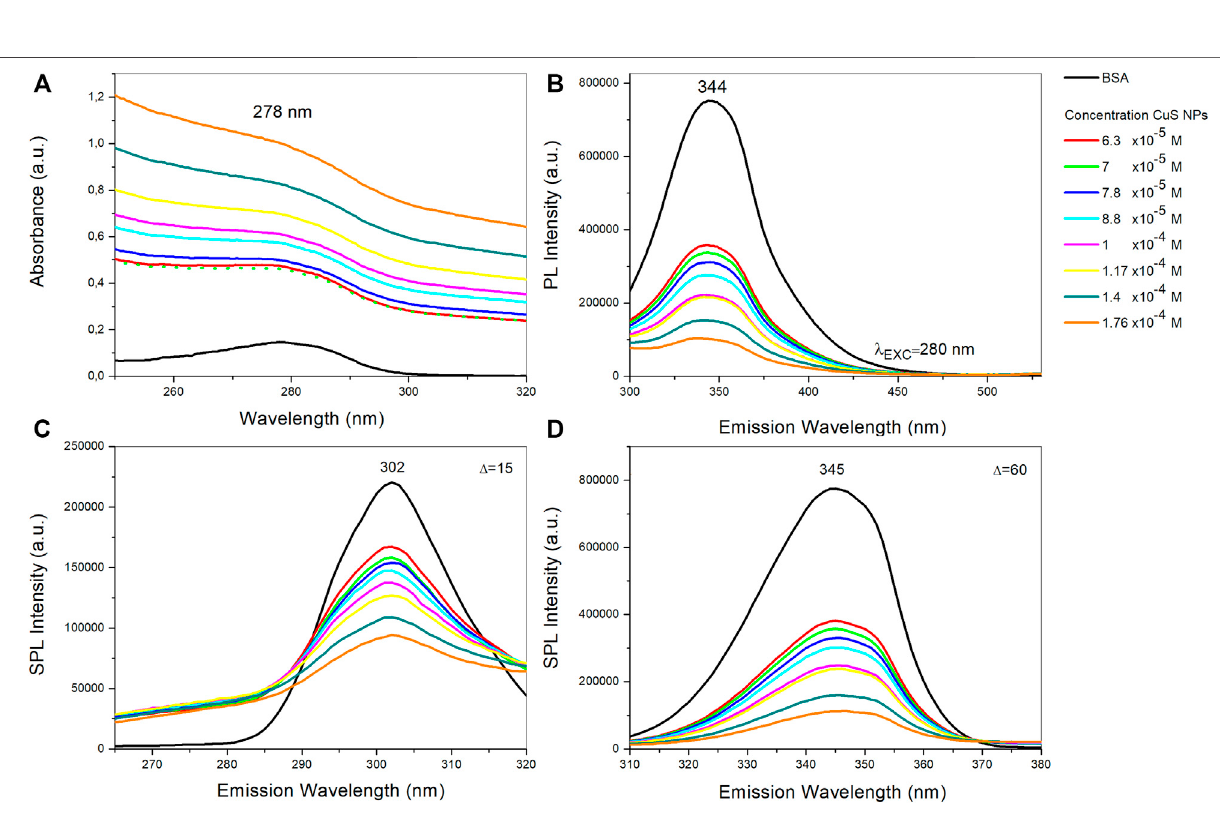
FIGURE7|(A) UV-Visabsorptionspectra, (B) fl uorescenceemissionspectra, (C) synchronous fl uorescencespectraat Δλ =15 nm,and (D) at Δλ =60 nmofBSA and BSA with various concentrations of CuS